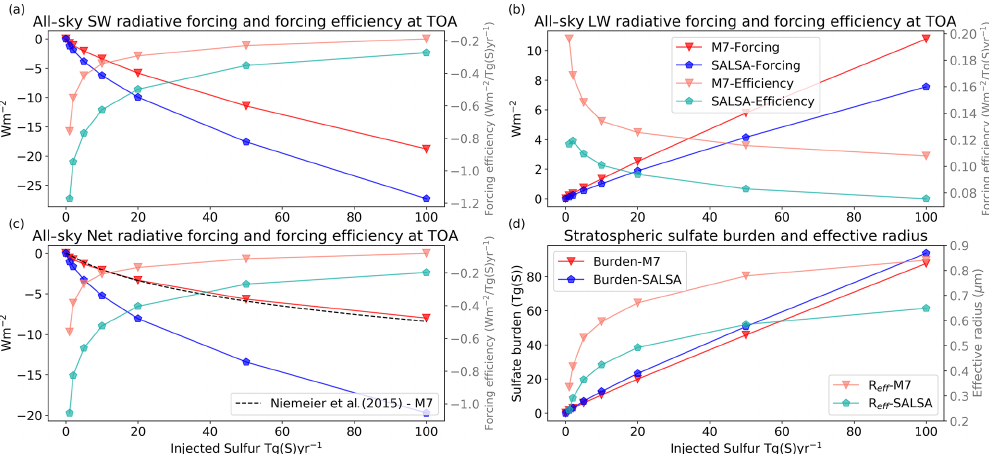
Figure 1. Global mean all-sky (a) short-wave, (b) long-wave, and (c) total (net) radiative forcing and forcing efficiency as well as (d) the stratospheric sulfate burden and the mean effective radius as a function of injection rate. The M7 results are shown using red lines and markers, and the SALSA results are indicated using blue. Faint colours (forcing efficiency in panels a–c and effective radius in panel d ) correspond to the right-hand faint axis.